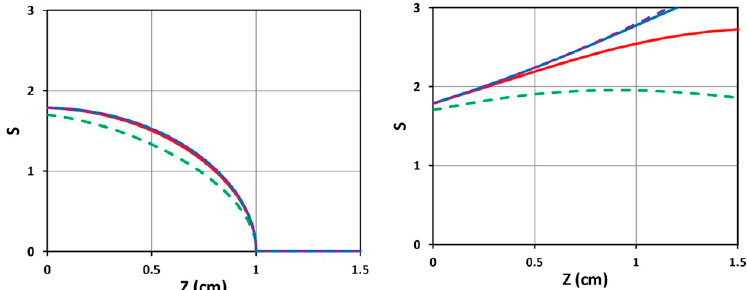
Figure 5. Spatial profiles of S for various exposure time t = (100, 200, 300, 400) s shown by (green, red, blue, purple) curve, for fixed light intensity I 0 = 10 (mW/cm 2 ) and C 0 = 2 mM, for D = 1.0 cm ( left figure ) and D = 10 cm ( right figure ).